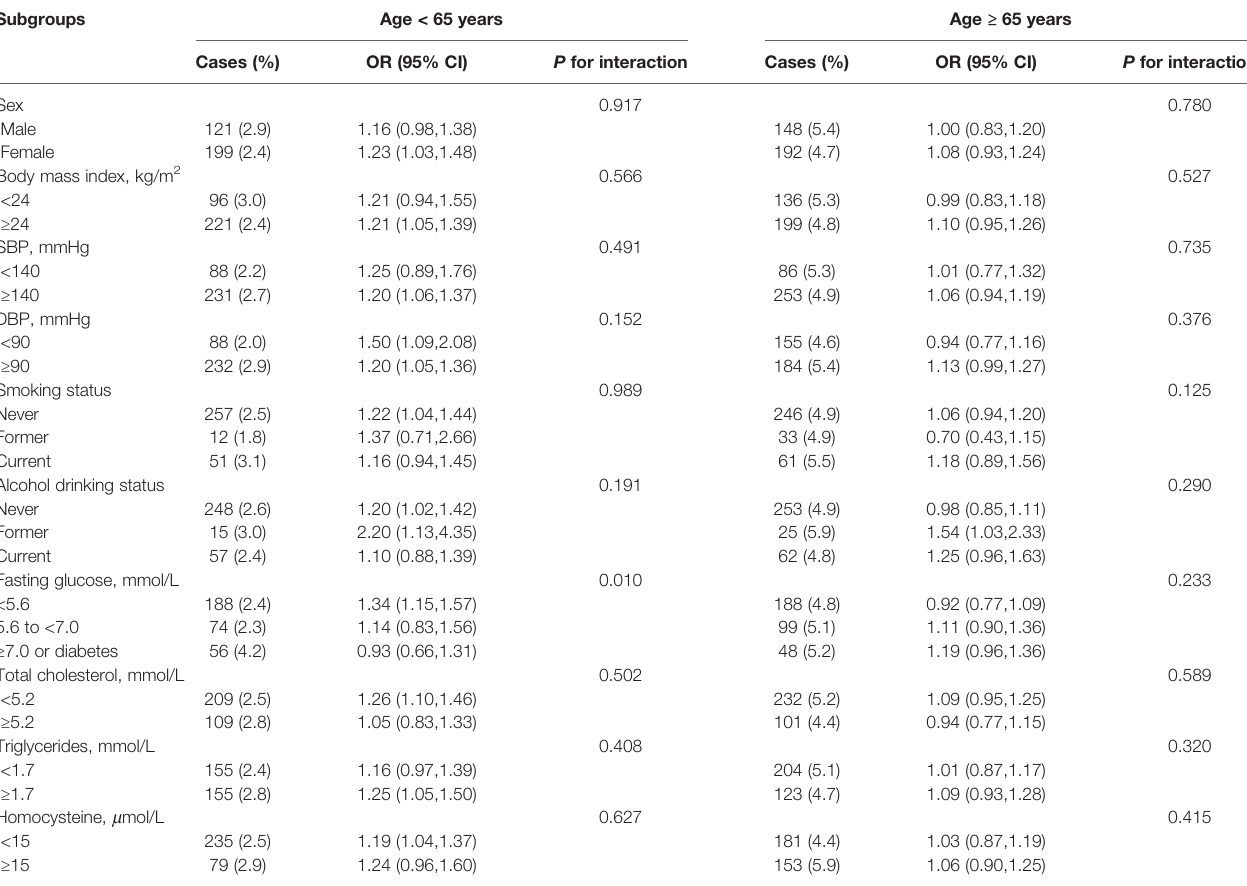
Each subgroup analysis was adjusted, if not strati fi ed for age, sex, body mass index, systolic blood pressure (SBP), diastolic blood pressure (DBP), smoking status, alcohol consumption, baselinefastingbloodglucose,totalcholesterol,triglycerides,homocysteine,andhistoryofantihypertensivedruguse.Dataarepresentedasmedian(IQR)orn(%),unlessotherwiseindicated.